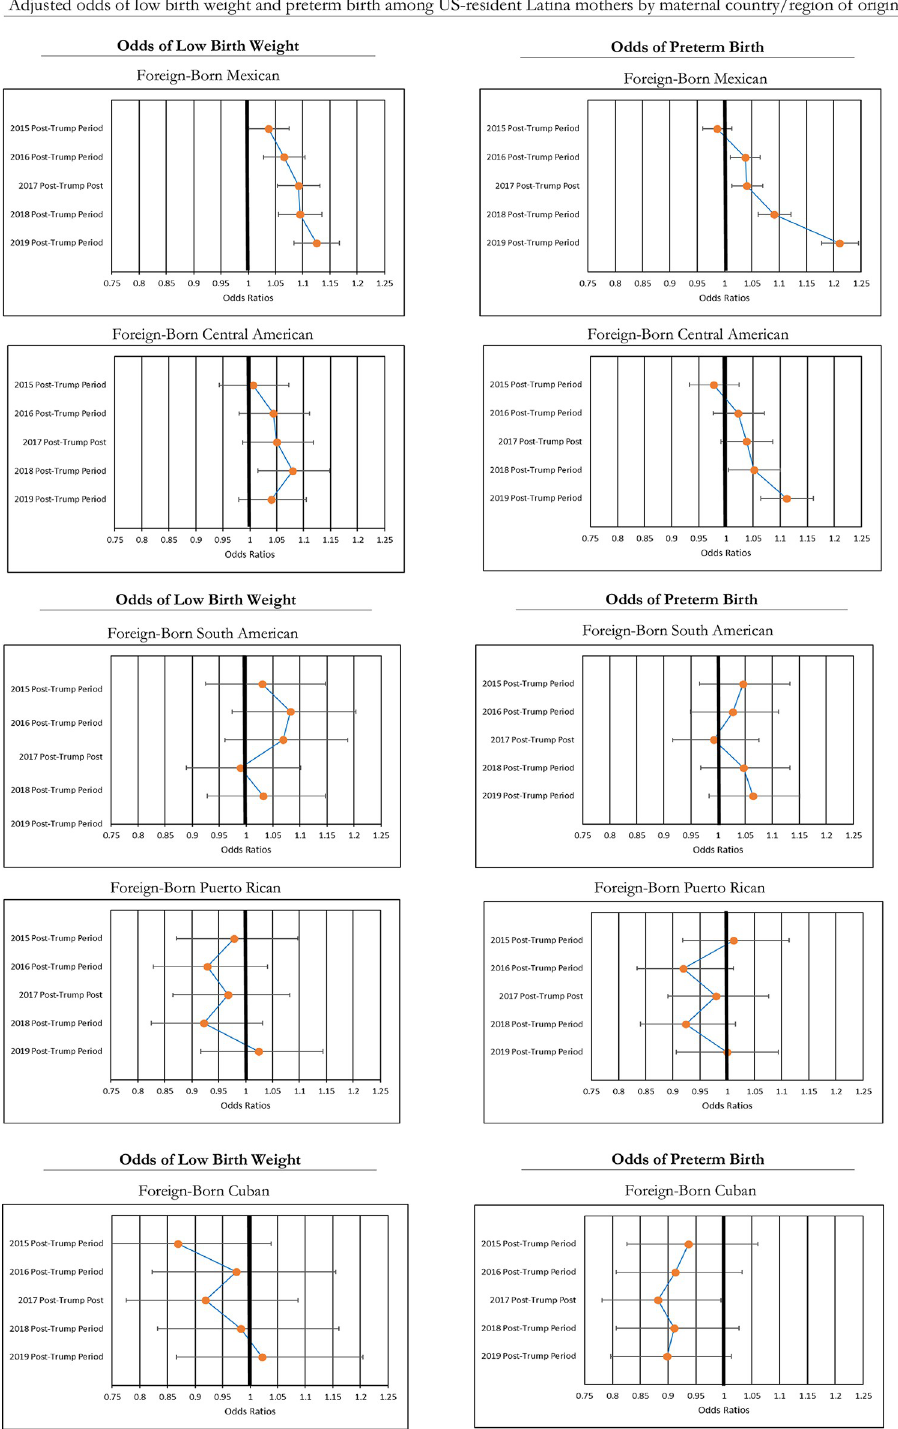
Fig 2. Adjusted odds of low birth weight and preterm birth, relative to pre-trump period by maternal country/ region of origin.